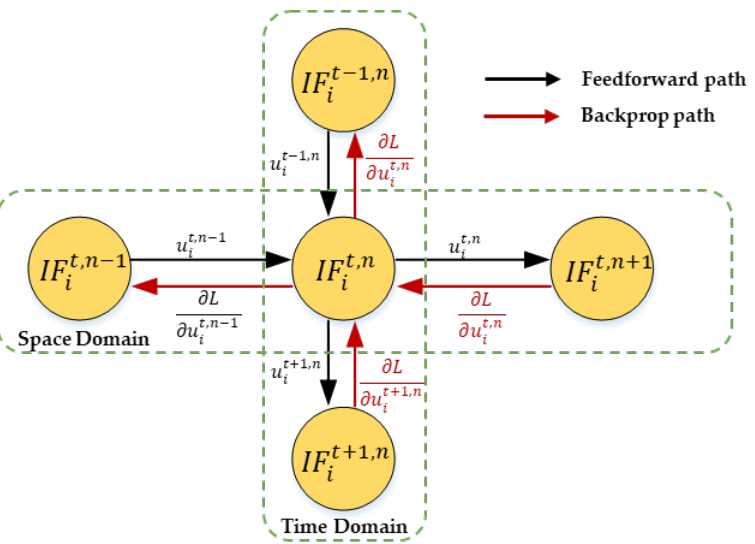
Figure 6. Spatio-temporal backpropagation in spike neural network. At the single-neuron level, the vertical path and horizontal path represent the loss L_total propagation in the space domain and time domain,